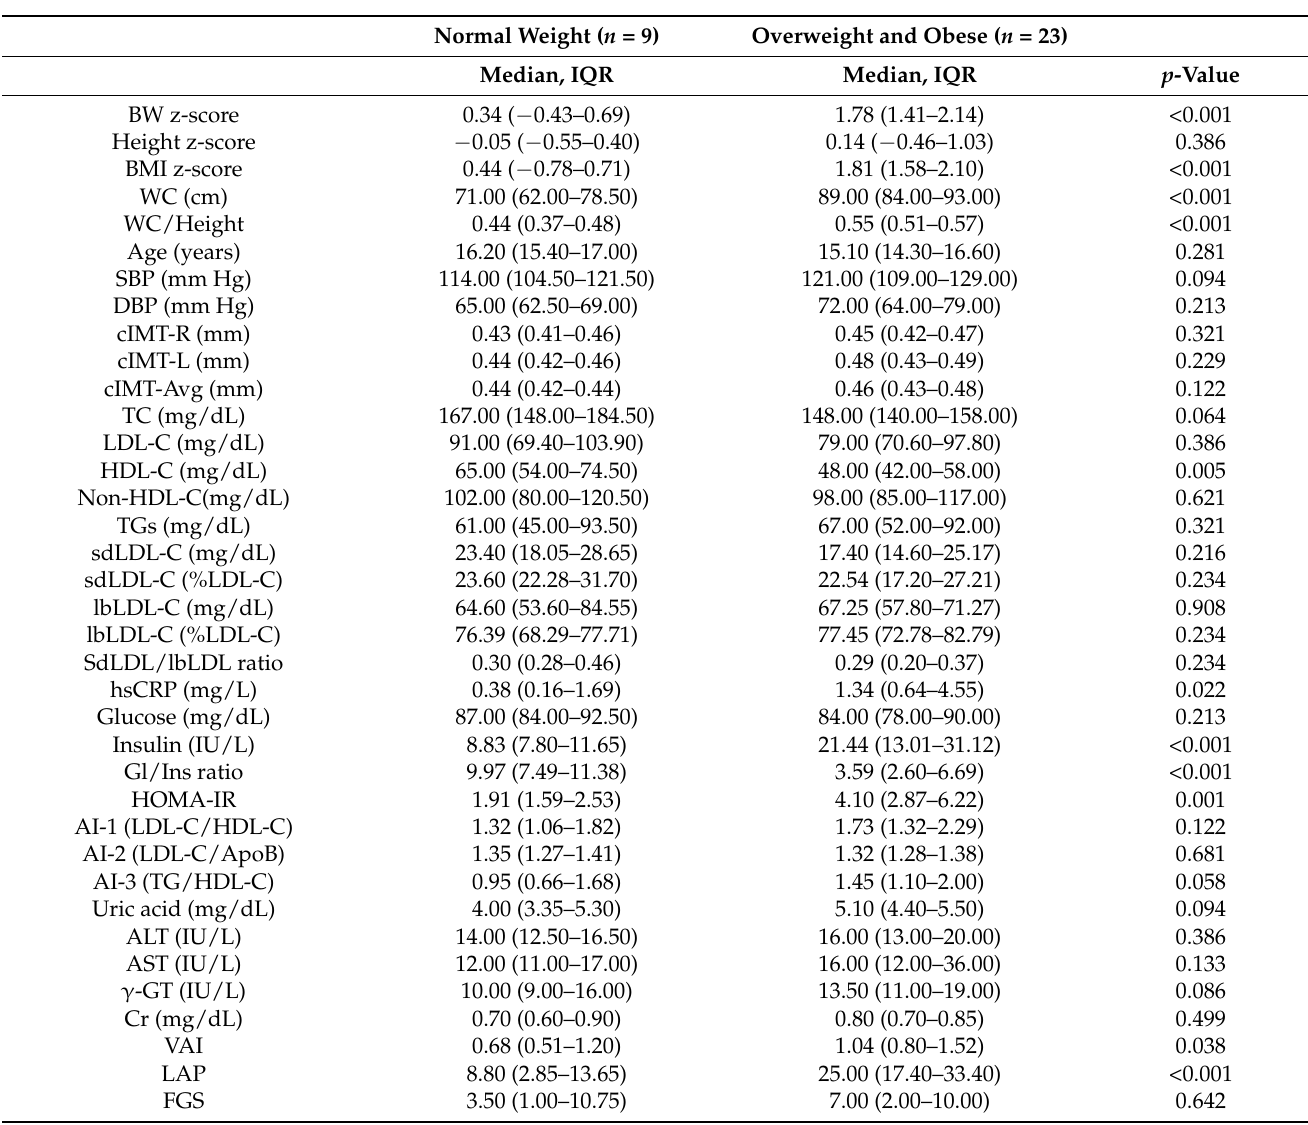
Table 1. Correlation of clinical, biochemical, and imaging variables with increased BMI